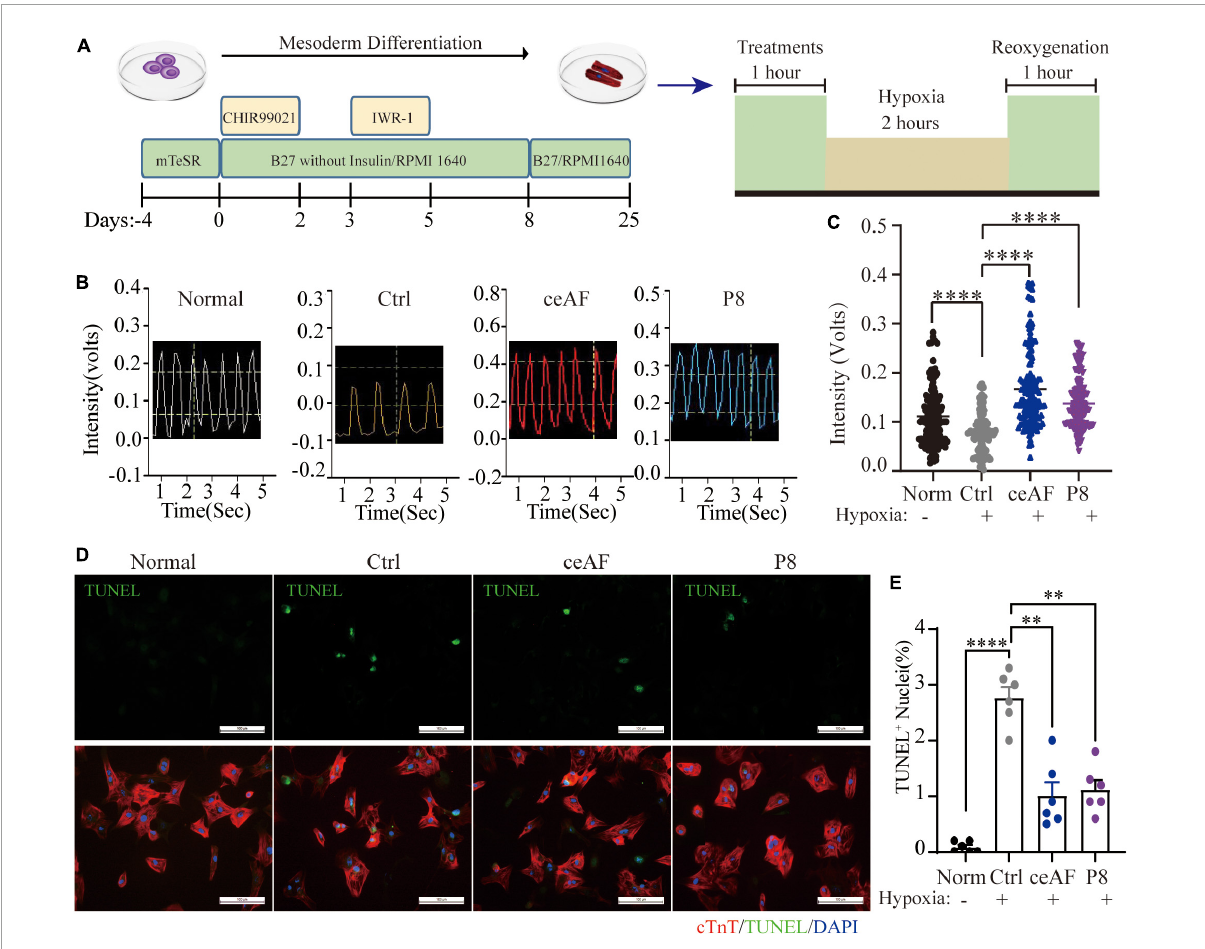
FIGURE3 P8 protects hESC-derived cardiomyocytes from the harmful effects of hypoxia/reoxygenation. (A) The schematic protocol used for hESC differentiation into cardiomyocytes. Differentiated cardiomyocytes were pretreated with or without P8 for 1 h, hESC-derived CMs were suffered either normoxia or hypoxia in a hypoxic cell incubator (1 O 2 , 5 CO 2 , and 94% N 2 ) for 2 h followed by 1 h of reoxygenation. (B) Representative traces of contraction force recording of hESC-derived CMs pretreated with 20% ceAF, 20% P8 or DMEM and hypoxia/reoxygenation process. n = 6 per group. (C) Quantification of relative contraction force of hESC-derived cardiomyocytes treated with 20% ceAF, 20% P8 or DMEM and hypoxia/reoxygenation process. Each point in the figure represents the contractility of a single cardiomyocyte. (D) TUNEL and TNNT2 staining of hESC-derived cardiomyocytes suffered either normoxia or hypoxia in a hypoxic cell incubator (1 O2, 5 CO2, and 94% N2) for 2 h followed by 1 h of reoxygenation ( n = 6 per group). (E) Percent TUNEL + nuclei in hESC-derived cardiomyocytes after hypoxia/reoxygenation process with or without P8 treatment ( n = 6 per group). Scale bar: 100 µ m. ** p < 0.01; **** p <